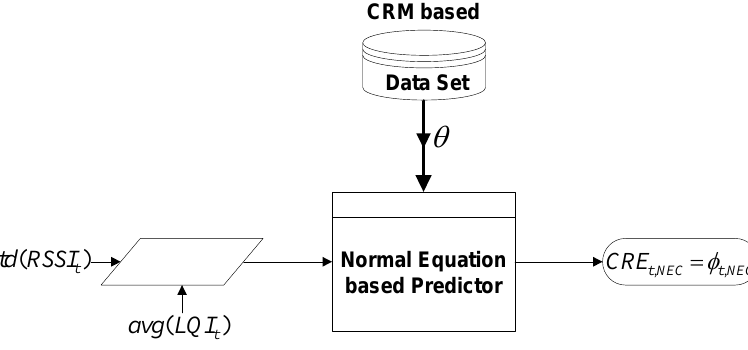
Figure 3. Data flow diagram of the